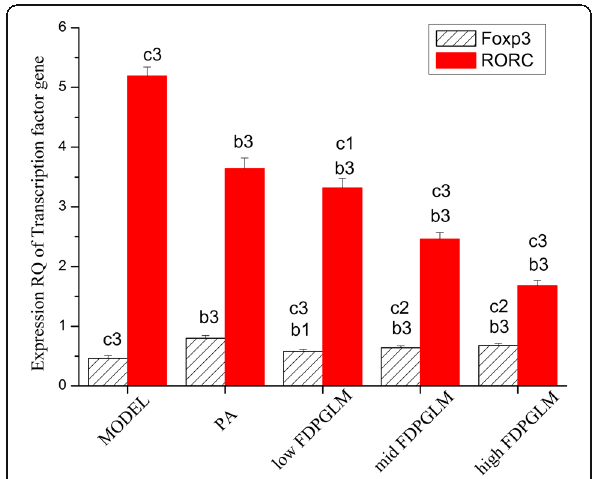
Fig. 5 Effect of FDPGLM on the expression of the Foxp3 and ROR γ t transcription factor gene in pathological